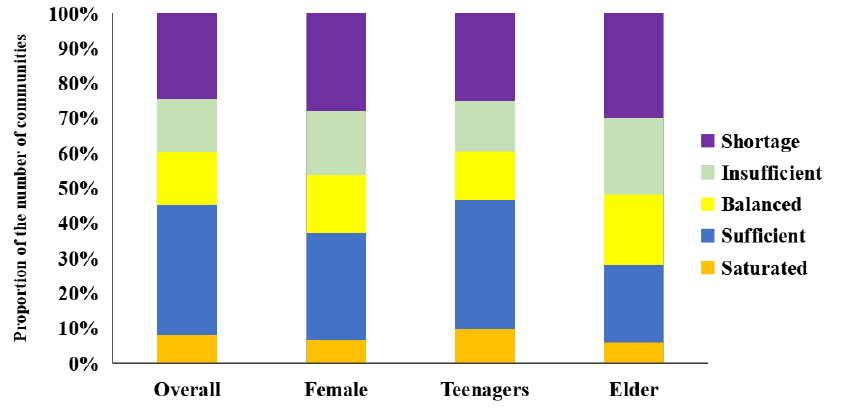
Figure 8. Proportion of communities of different groups at different supply and demand levels.